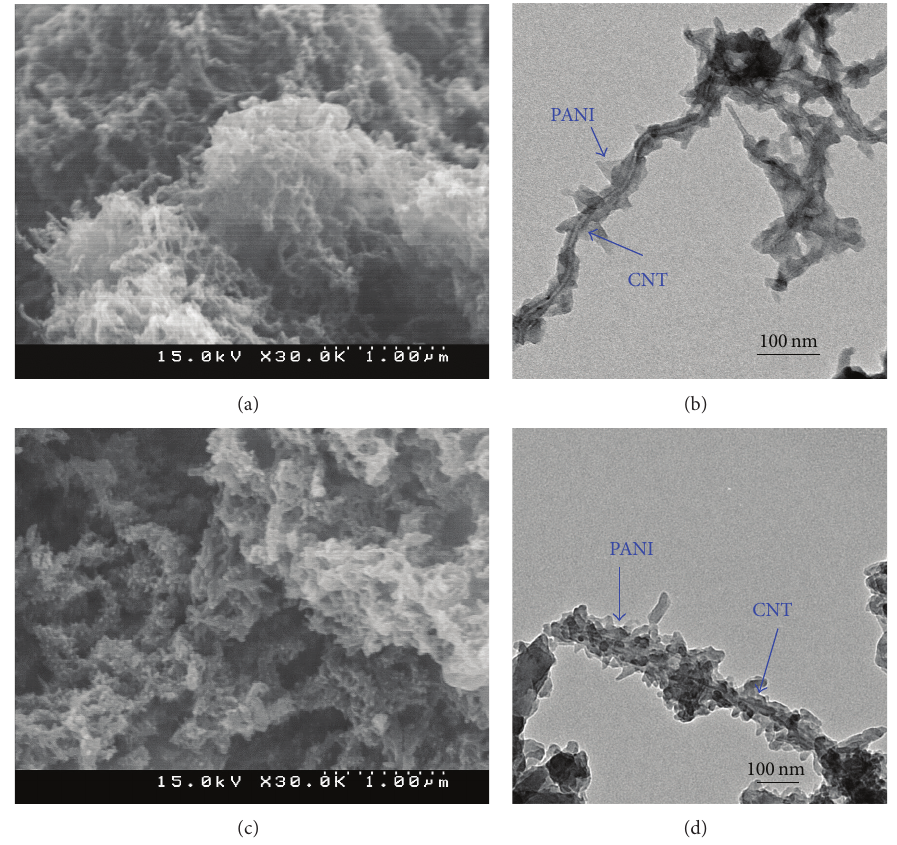
Figure 1: SEM (a, c) and TEM (b, d) images of CNT/PANI composites prepared in HCl (a, b) and HNO 3 (c, d)